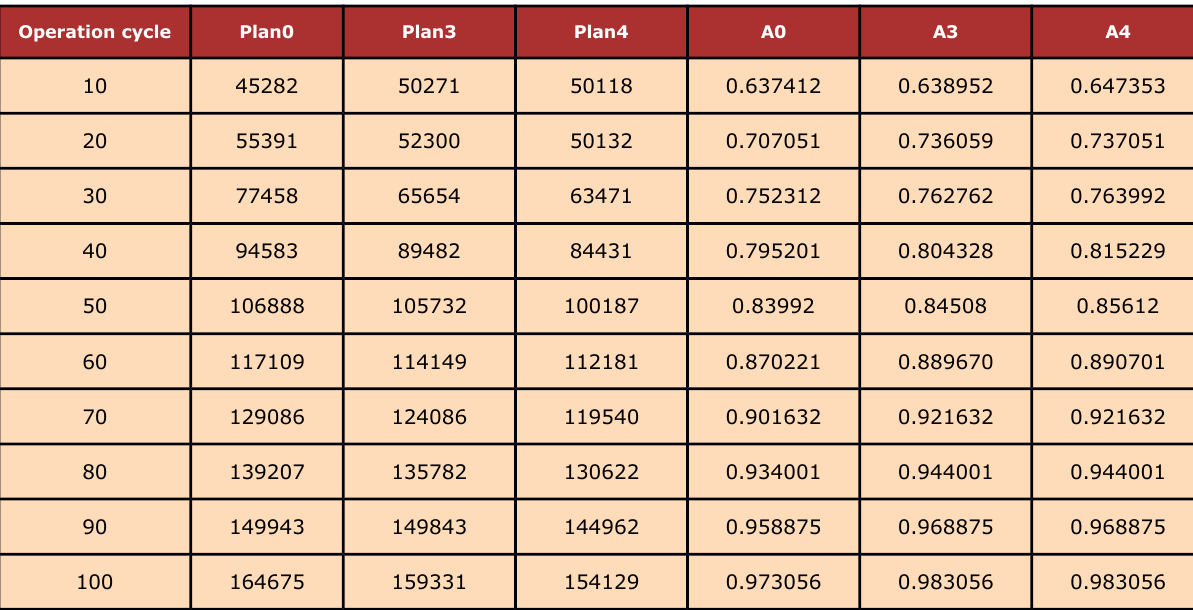
Table 2. All-in support cost and operational availability